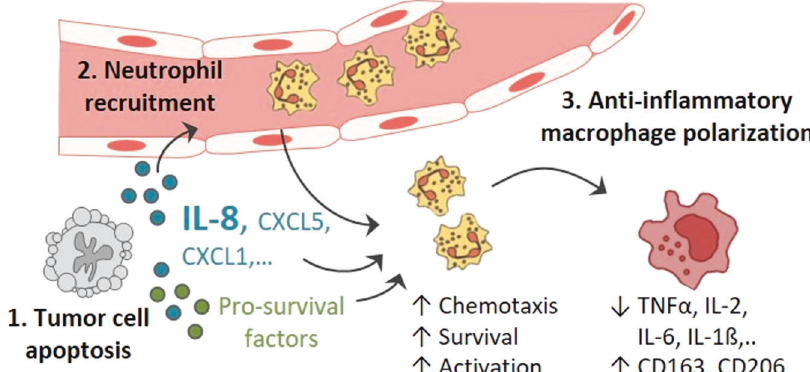
Fig. 7 Proposed model illustrating apoptotic tumour cell-induced modulation of the CRC immune microenvironment. Apoptotic tumour cells release soluble factors, amongst others IL-8, stimulating neutrophil chemotaxis, survival and activation. Recruited neutrophils then shape the tumour microenvironment by inducing an anti-in fl ammatory macrophage